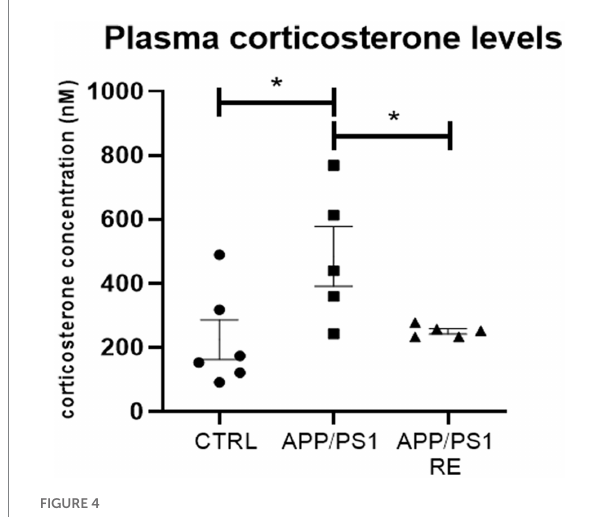
FIGURE 4 Resistance exercise decreased plasma corticosterone levels in APP/ PS1 mice. Values (mean ± standard error of the mean) represent plasma corticosterone concentration (nM). One-way